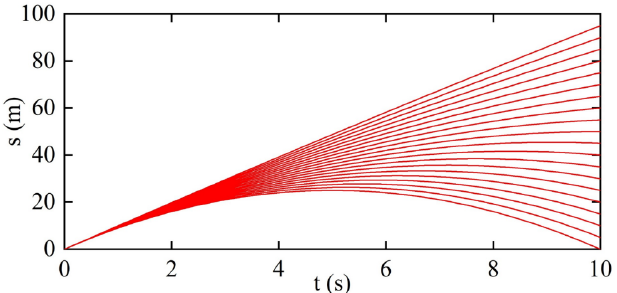
Figure 6. Distance prediction under different acceleration.